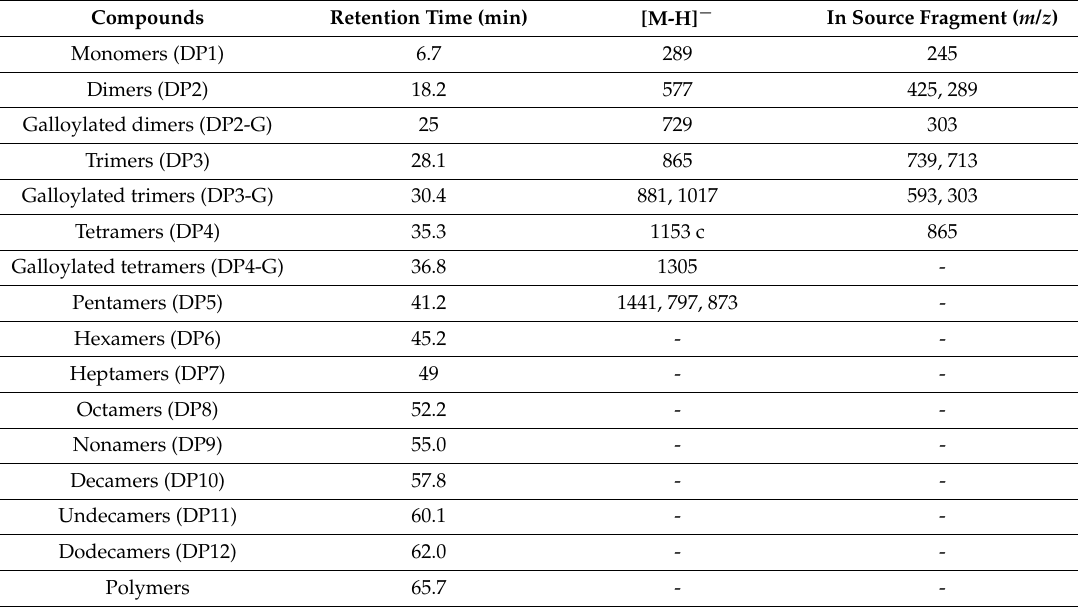
Figure 1. Grape seed extracts flavan-3-ols profile as obtained by normal phase HPLC separation. Table 1. Analytical parameters of HPLC–FLD-ESI-MS